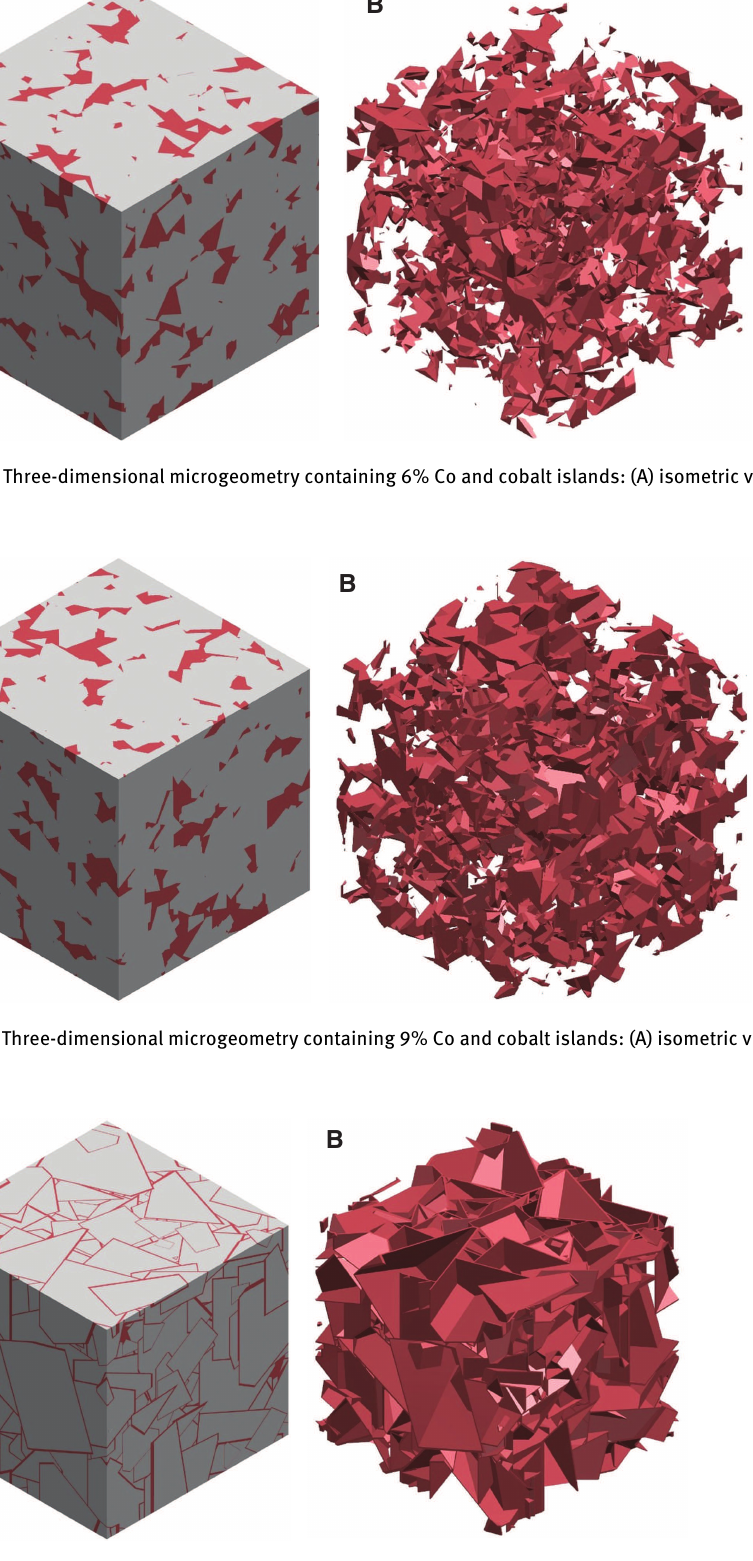
Figure 6: Three-dimensional microgeometry containing 6% Co and continuous boundaries between tungsten carbide particles: (A) isometric view and (B) detailed view on the cobalt